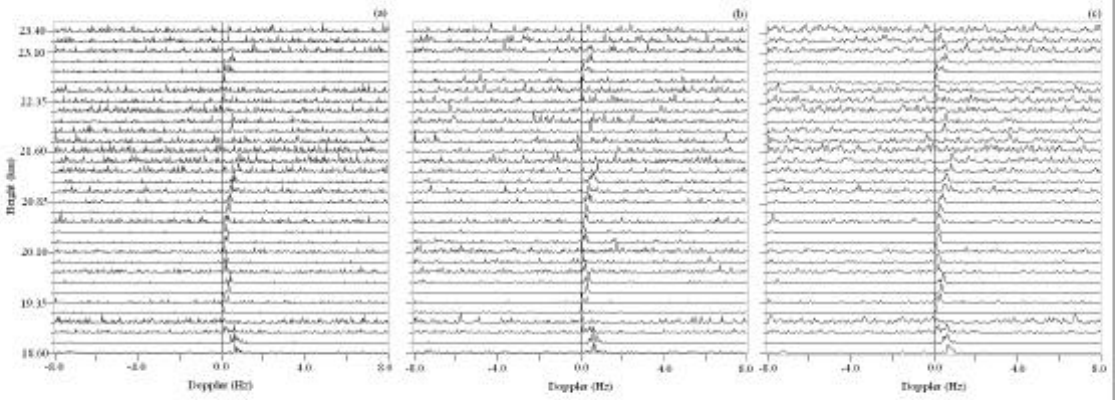
Fig. 2. Power spectra estimated using (a) rectangular taper, (b) Hanning taper and (c) sinusoidal taper- order 3 for the west 10 ◦ beam on 10 May 2002. Table 1. Number of range gates failed in detecting the correct mean Doppler frequency and standard deviation of more than 0.5Hz over the average mean Doppler, using sinusoidal (S), Hanning (H) and rectangular (R) tapers on 10 May 2002. West 10 ◦ beam Zenith beam North 10 ◦ beam 10 May 2002 S